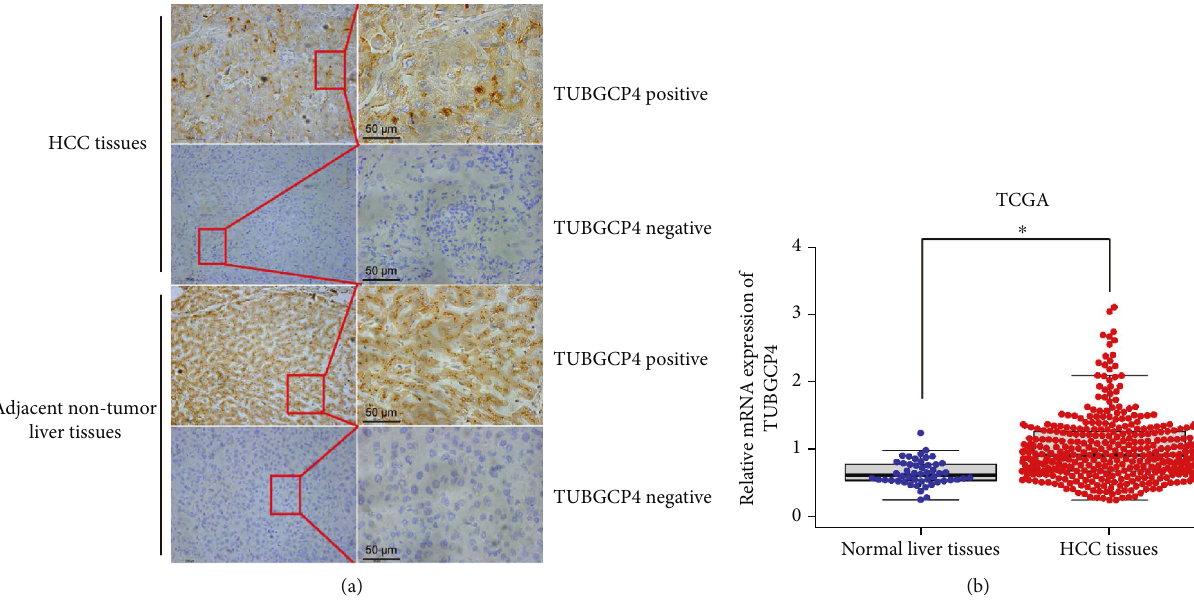
Figure 1: TUBGCP4 expression in HCC tissues. (a) Representative TUBGCP4 protein expression was detected in HCC and its adjacent tissues. (b) The expression of TUBGCP4 in HCC and normal liver tissues from TCGA database, ∗ indicates P < 0 : 05 . Table 2: TUBGCP4 expression in paired HCC tissues and adjacent nontumor